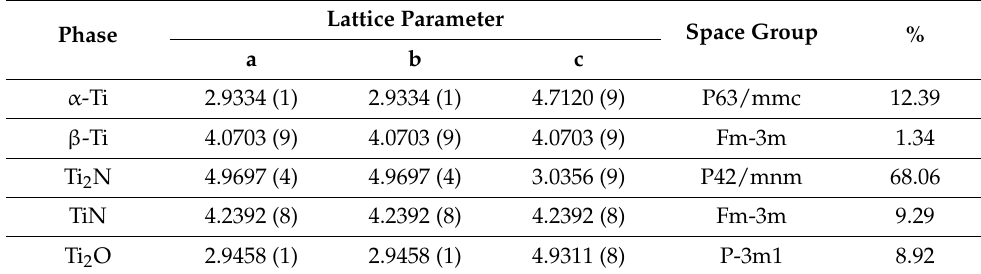
Figure 4. X-ray diffraction pattern of the nitrided surface. Table 2. Phase composition and lattice parameters of the nitrided surface.